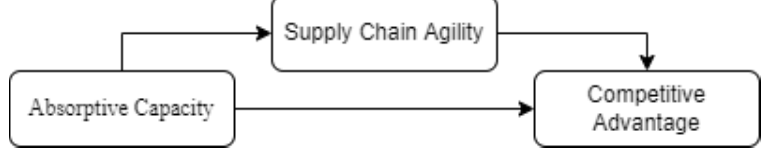
Figure 1: A Research Framework; Sources : Lis & Sudolska, 2015; Wu et al, 2017; Martinez-Sanchez & Lahoz-Leo, 2018; Lo & Tian,